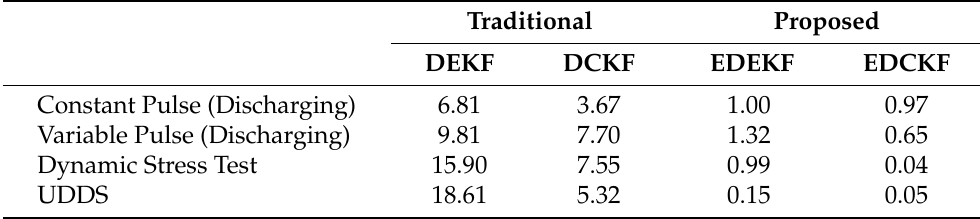
Figure 3. Performance evaluation of the dual Kalman filter variants in different battery cycles. Table 1. Mean absolute estimation